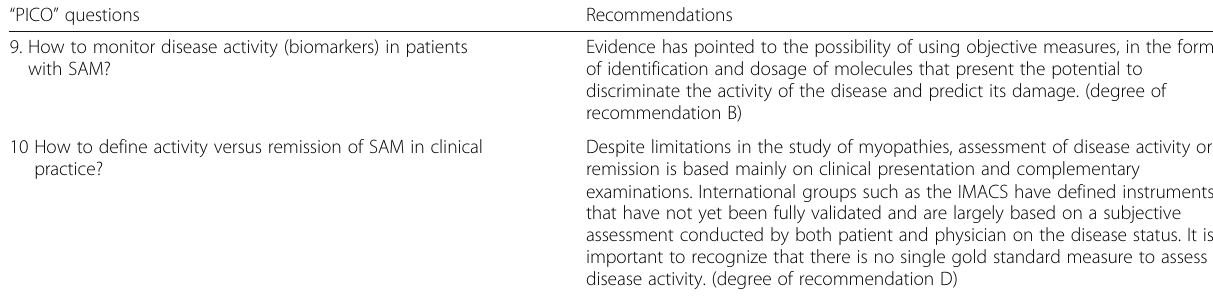
Table 3 Recommendations for the treatment of systemic autoimmune myopathies